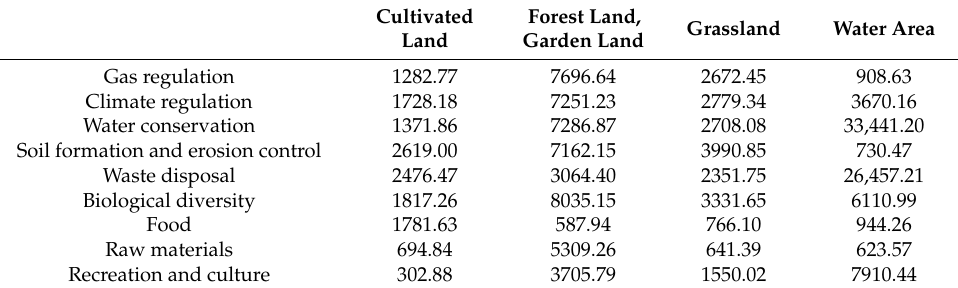
Table 1. The ecological service value of per unit of cultivated land, forest land, garden land, grassland, and water area in W County (yuan/hm 2